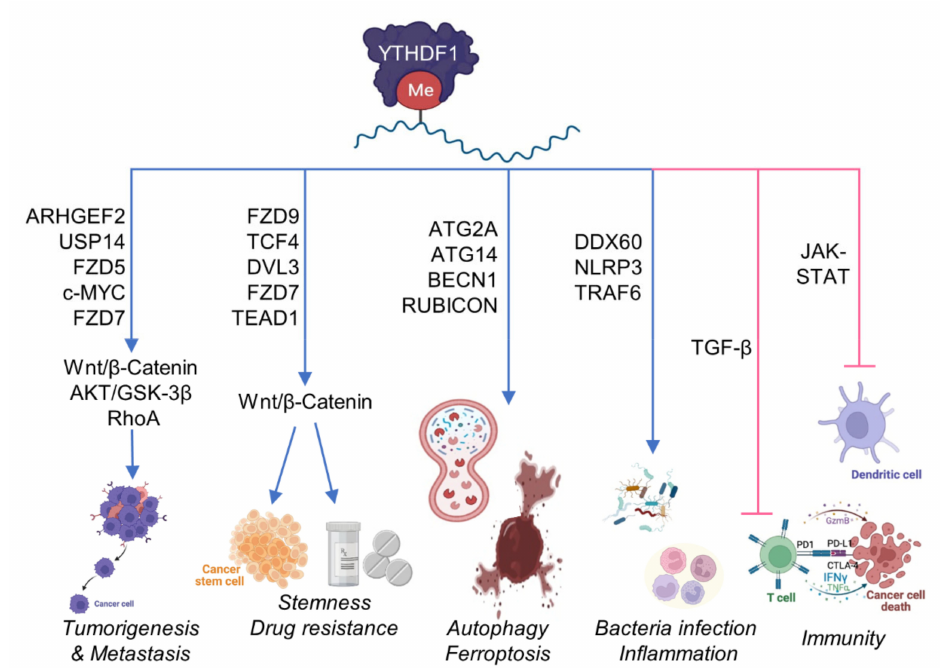
Figure 1. Multifaceted role of YTHDF1 in gastrointestinal cancers. YHTDF1-driven translation of m 6 A-modified gene targets has been shown to confer malignant phenotypes that are associated with cancer cell intrinsic properties (proliferation, metastasis, stemness and cell death) as well as its interaction with the tumor microenvironment (inflammation and immunity). Part of the figure is created with